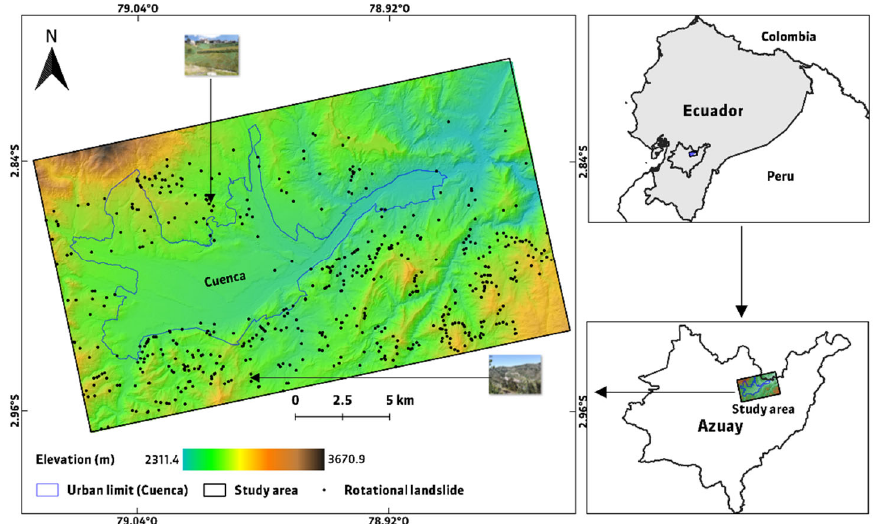
Figure 1. Map of study area with rotational landslides registered in landslides inventory.